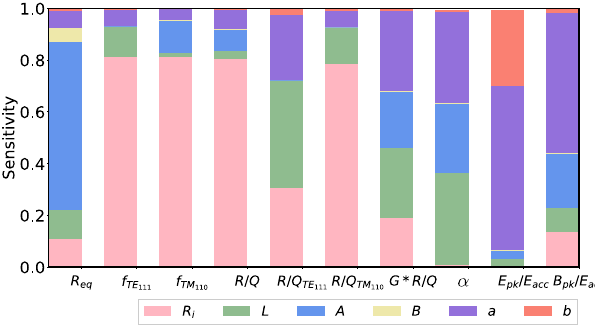
FIG. 7. Main sensitivities. For a point ð R i ; L; A; B; a; b Þ inside the intervals from Table II, f is tuned to 400.79 MHz using FM ∈ ½ 325 ; 375 (cid:2) . The polynomial degree is p ¼ 2 , so the R eq ½ mm (cid:2) size of the sample is 140 [cf. Table I].